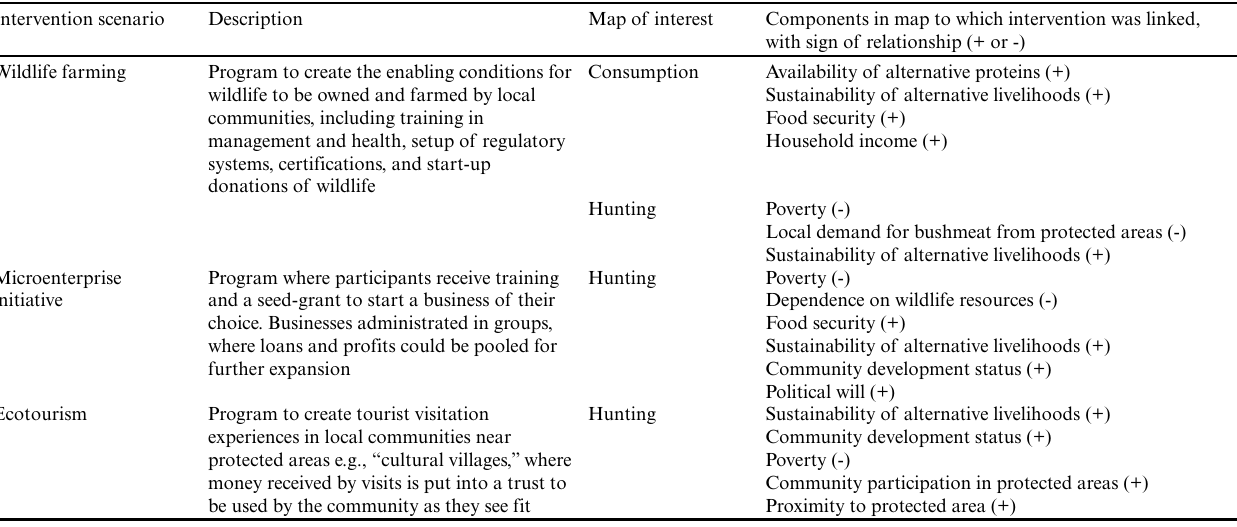
Table 1 . Description of intervention scenarios and their perceived relationships to other components in the fuzzy cognitive maps. Intervention